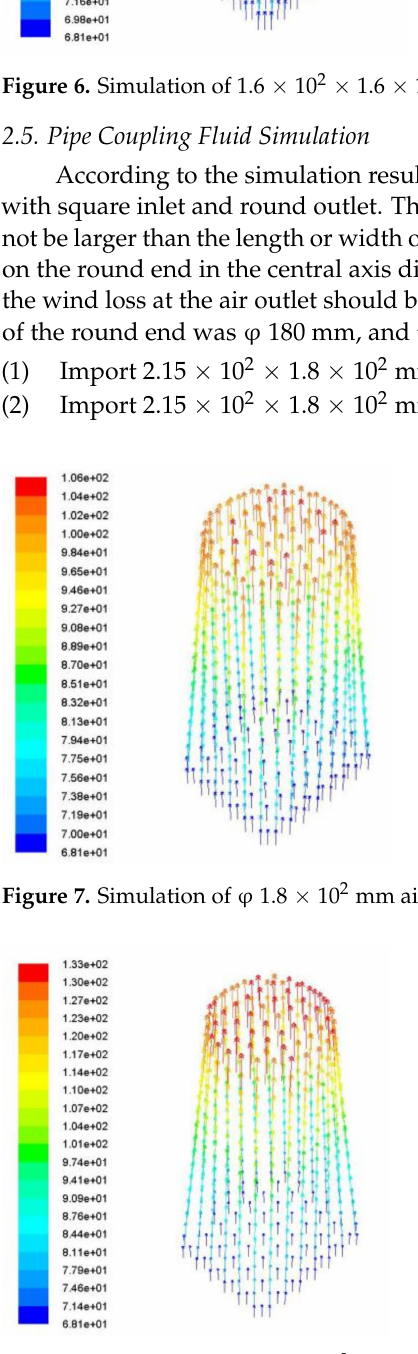
Figure 8. Simulation of ϕ 1.6 × 10 2 mm